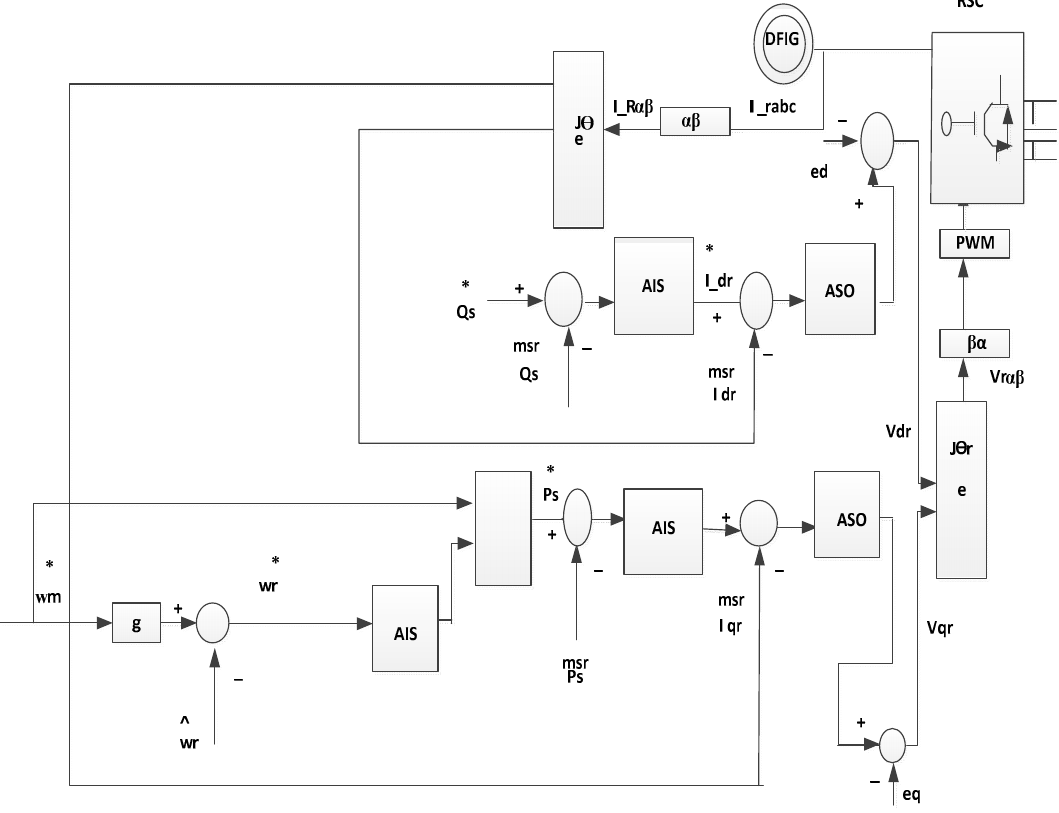
Figure 1. The Rotor Side Converter overall control scheme.